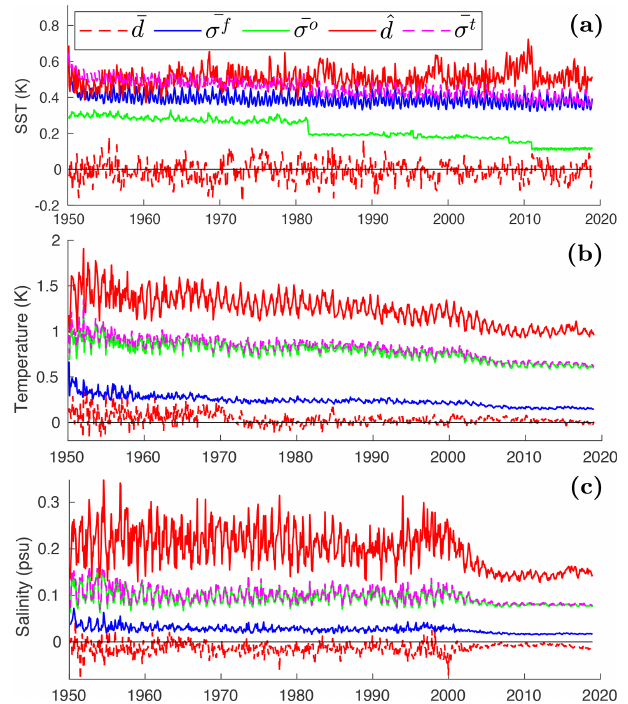
Figure 2. Global assimilation statistics (see Sect. 3.1.1 for defini- tions). Bias d (dashed red lines), ensemble spread ( σ f ; blue lines), observation error ( σ o ; green lines), RMSE ( ˆ d ; solid red lines) and the total error ( σ t ; pink lines) for SST (a) , ocean temperature (b) and ocean salinity (c)